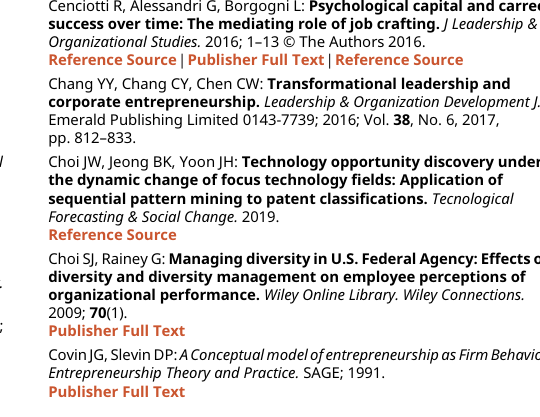
Figshare: List of questions and descriptions of the questionnaire - Transformational Entrepreneurship. https://doi.org/ 10.6084/m9.figshare.15091182.v3 (Gunawan et al., 2021b).